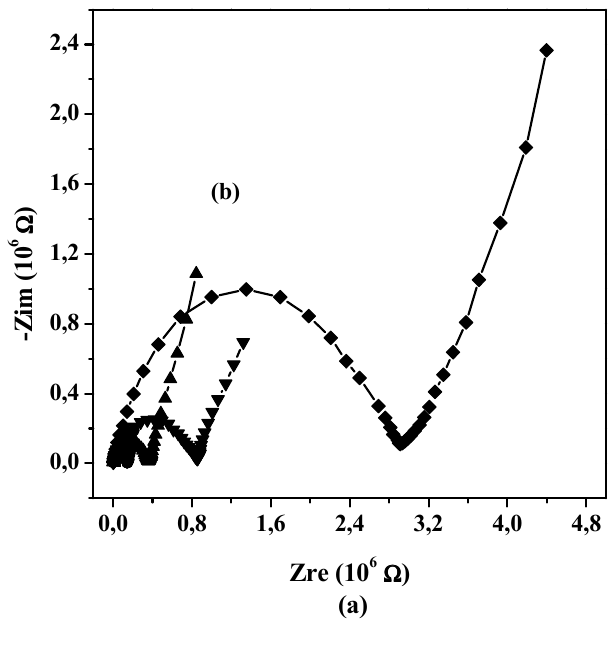
Figure 4. (a) Impedance spectra obtained for the PVC-SR membrane electrodes in a 50 mM citrate pH 5.5 buffer in the frequency range of 100 KHz-10 mHz ( (cid:1) PVC (cid:2)(cid:3) (cid:2) 5.0 wt % (cid:4) (cid:2) 10.0 wt % (cid:5) (cid:2) 15.0 wt % (cid:6) 23.5 wt %.), and (b) Equivalence circuit used to model the behaviors of impedance spectra reported in Figure